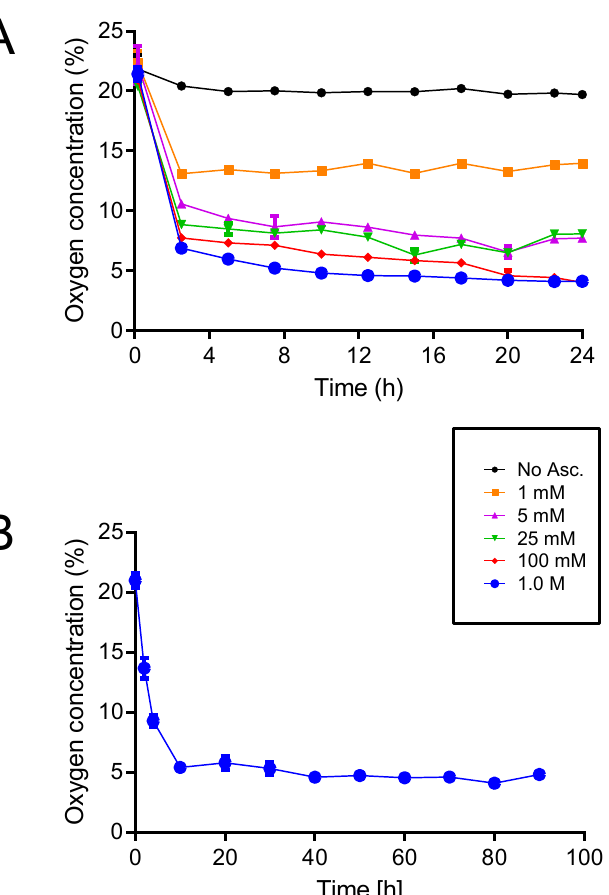
Figure 2. Oxygen concentrations measured within a device incubated with ascorbate bu ff er solutions of di ff erent concentrations ( N = 3; mean 4.91 ± 0.86 standard deviation)). ( A ) The evaluation of a sodium ascorbate (NaHAsc) solution with di ff erent concentrations (0.001–1 M) for 24 h. The oxygen concentrations decreased proportionally with increasing NaHAsc concentration. ( B ) The time course of the oxygen levels of 1 M NaHAsc. The lowest level of oxygen in the device could be maintained up to 90 h.